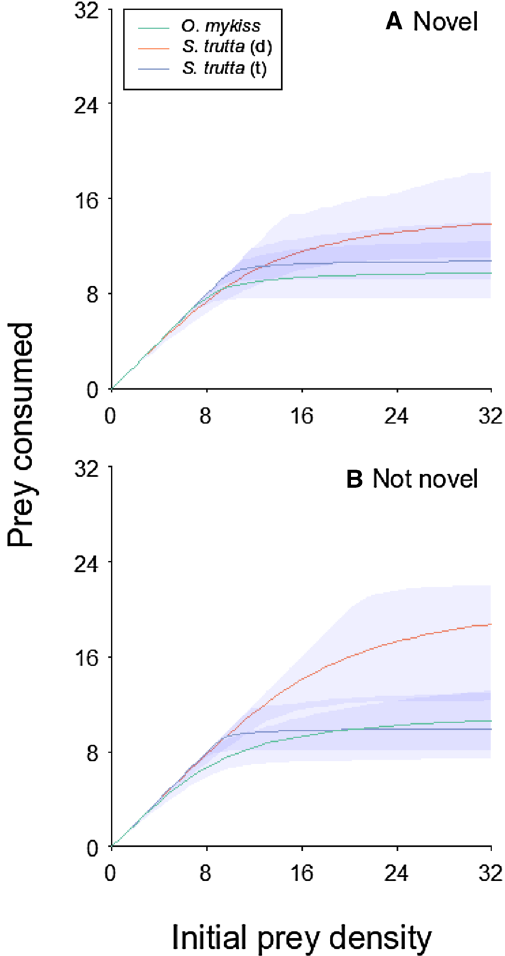
Figure 5. Functional Responses of diploid rainbow trout fry, diploid brown trout fry, and triploid brown trout fry under ( A ) novel prey conditions (i.e. fry had never fed on live chironomid prey previously) and ( B ) not novel conditions (i.e. fry had experienced live chironomid prey previously as part of the behaviour experiment). Clouds around lines represent bootstrapped 95% confidence